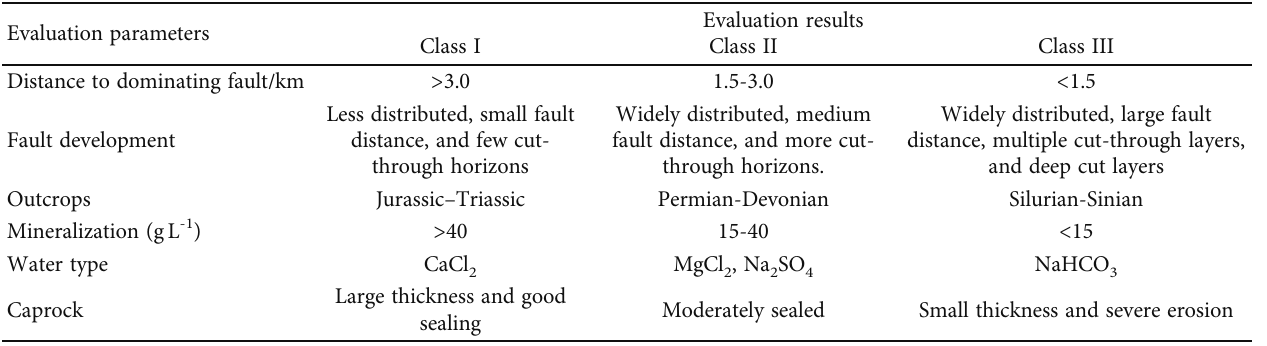
Table 2: The comprehensive evaluation system of the hydrocarbon preservation conditions of Cambrian formations.